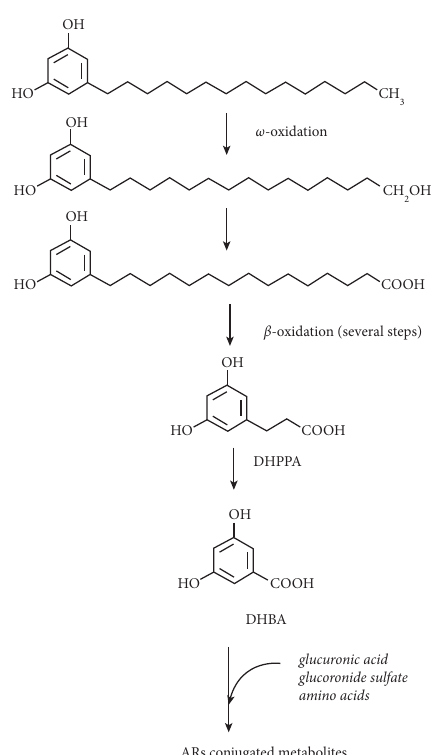
Figure 4: ARs metabolism in mammalian cells (pentadecylre- sorcinol (C15 :0) is shown as an example). Hydroxyl groups on the phenolic ring are conjugated with amino acids, glucuronide, and/or sulfate groups during